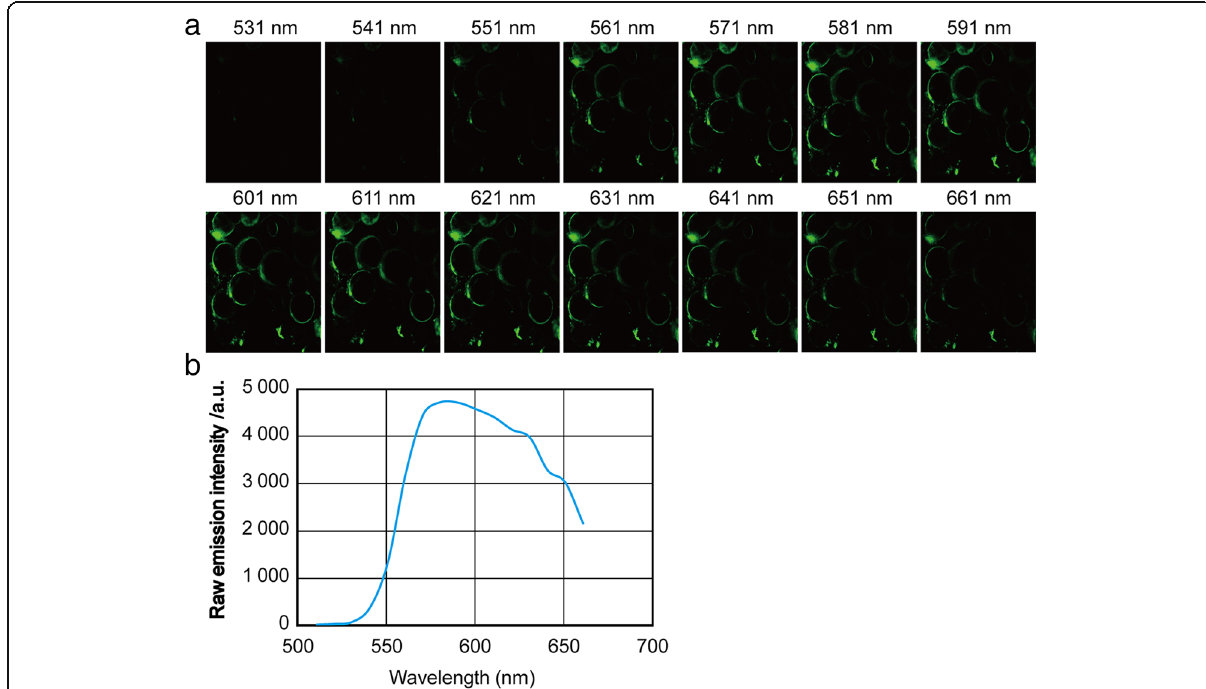
Fig. 2 Spectral characteristics of Di-4-ANEPPDHQ in cotton fiber cells. a Raw images series taken by the lambda mode of confocal laser scanning microscope (CLSM) in WT cotton fiber cell stained with di-4-ANEPPDHQ. b Raw emission profile of di-4-ANEPPDHQ in wild type cotton fiber